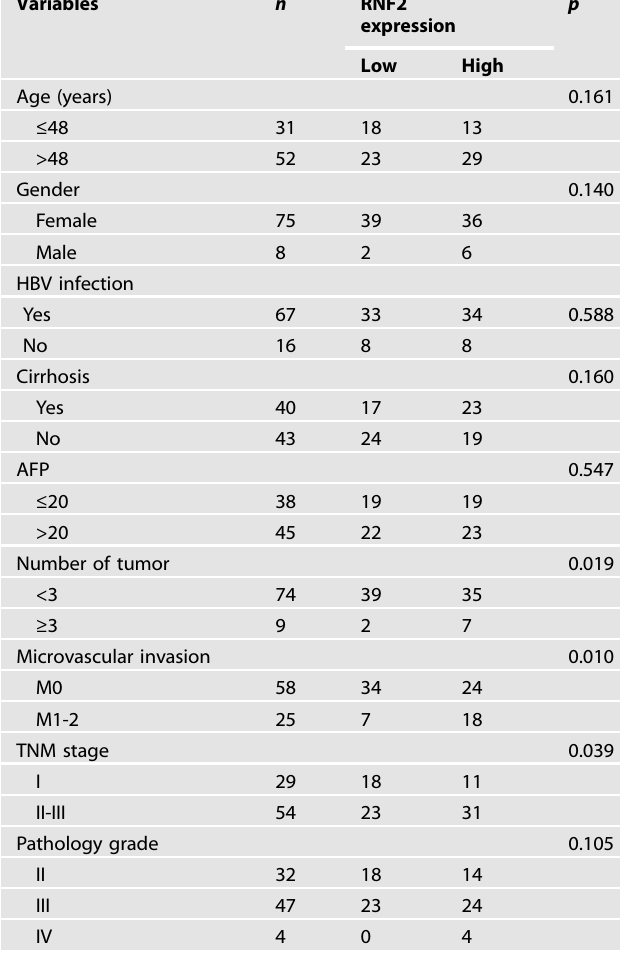
Table 1. Correlation analysis between RNF2 expression and clinical characteristics.